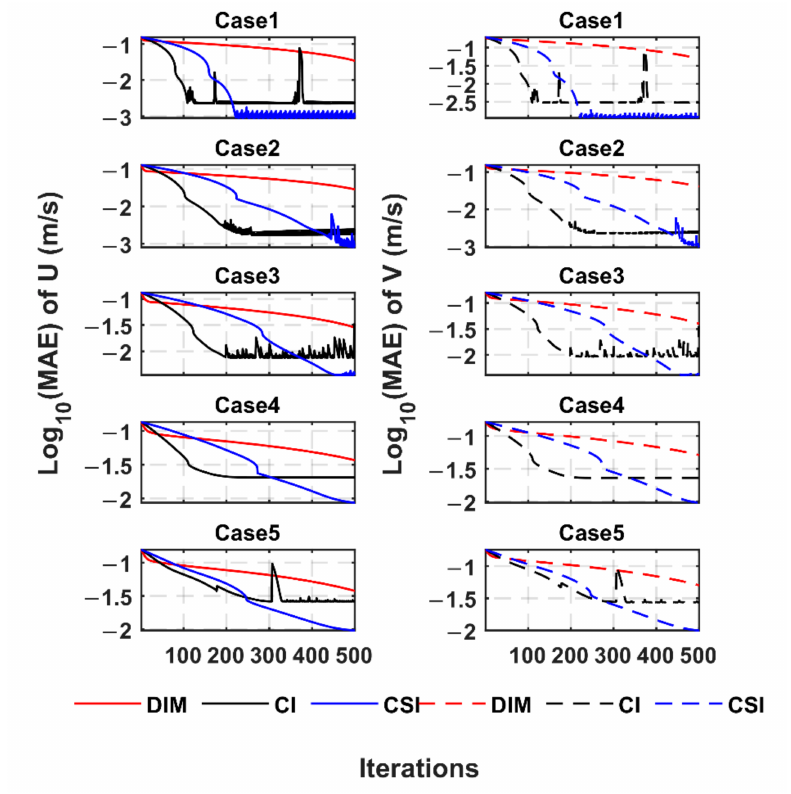
Figure 3. The MAEs between the observed and inverted velocity components (u and v) in Cases 1–5 (the figure shows the result after taking logarithm log 10